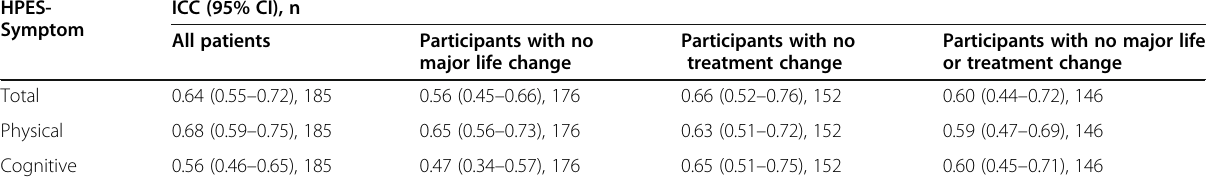
Table 2 Observational study HPES-Symptom test-retest reliability, baseline to week 2 HPES- ICC (95% CI), Symptom